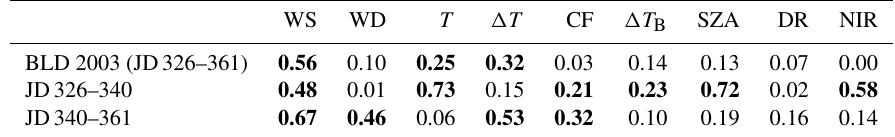
Table A2. Linear regression of BLD with observed meteorological variables in 2003. Bolding is the same as in Table A1. WS WD T (cid:49)T